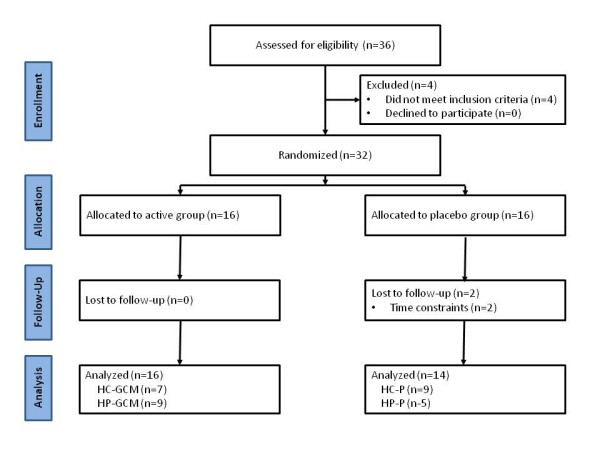
Participant flow diagram.